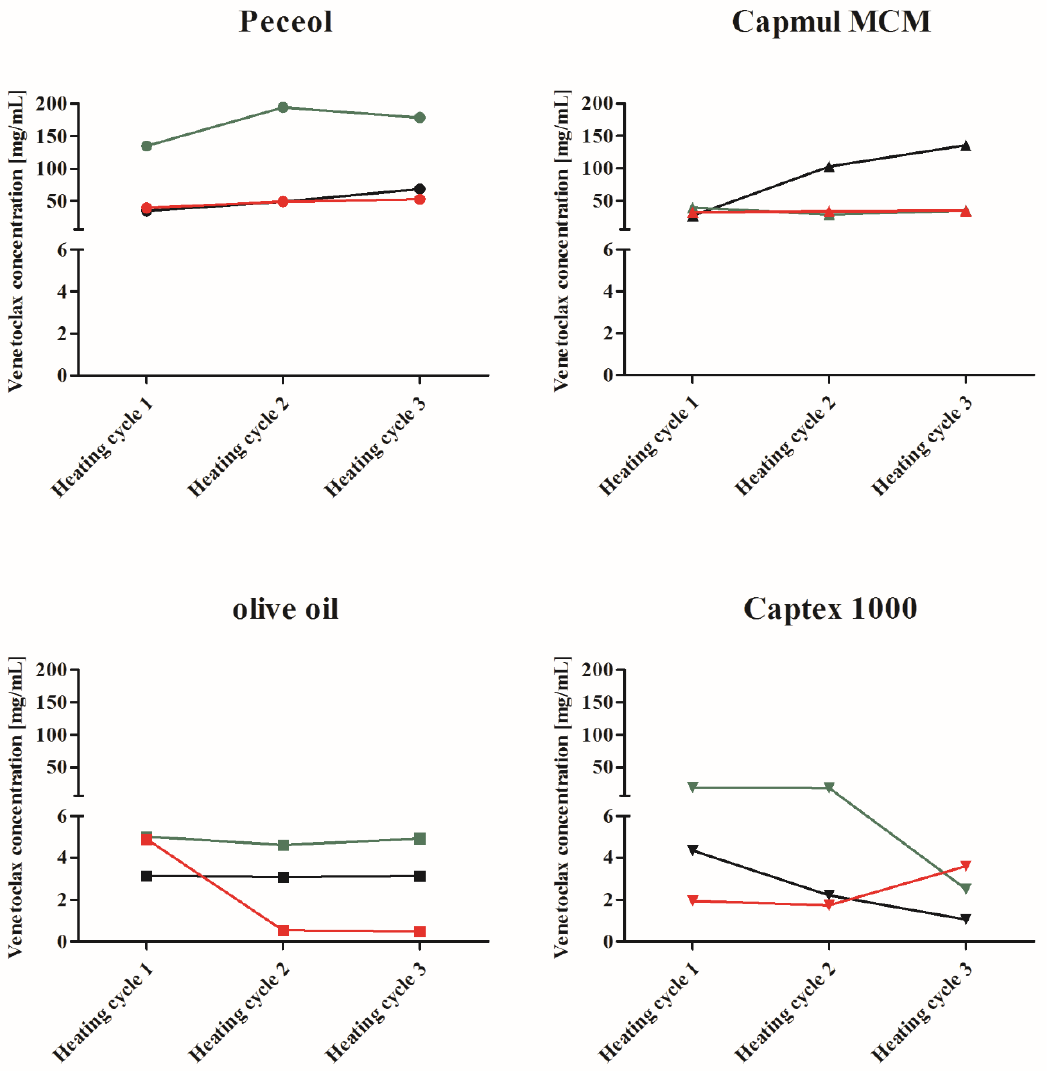
Figure 3. Venetoclax concentrations after each heating–holding (10 min)–cooling cycle to 70 °C in Peceol ® ( ● ), Capmul MCM ® ( ▲ ), olive oil ( ■ ) and Captex ® 1000 ( ▼ ). Batch 1 (black), batch 2 (green) and batch 3 (red), where n = 1 for initial screening.